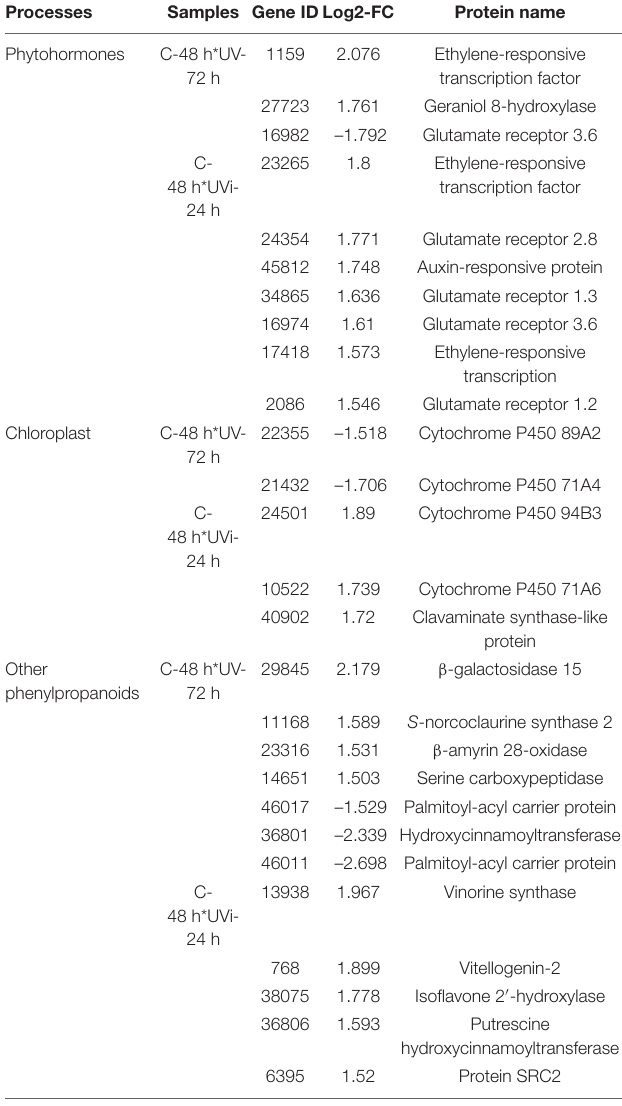
TABLE 6 | Relative expression of phytohormones, chloroplast, and phenylpropanoids biosynthesis genes. Processes Samples Gene